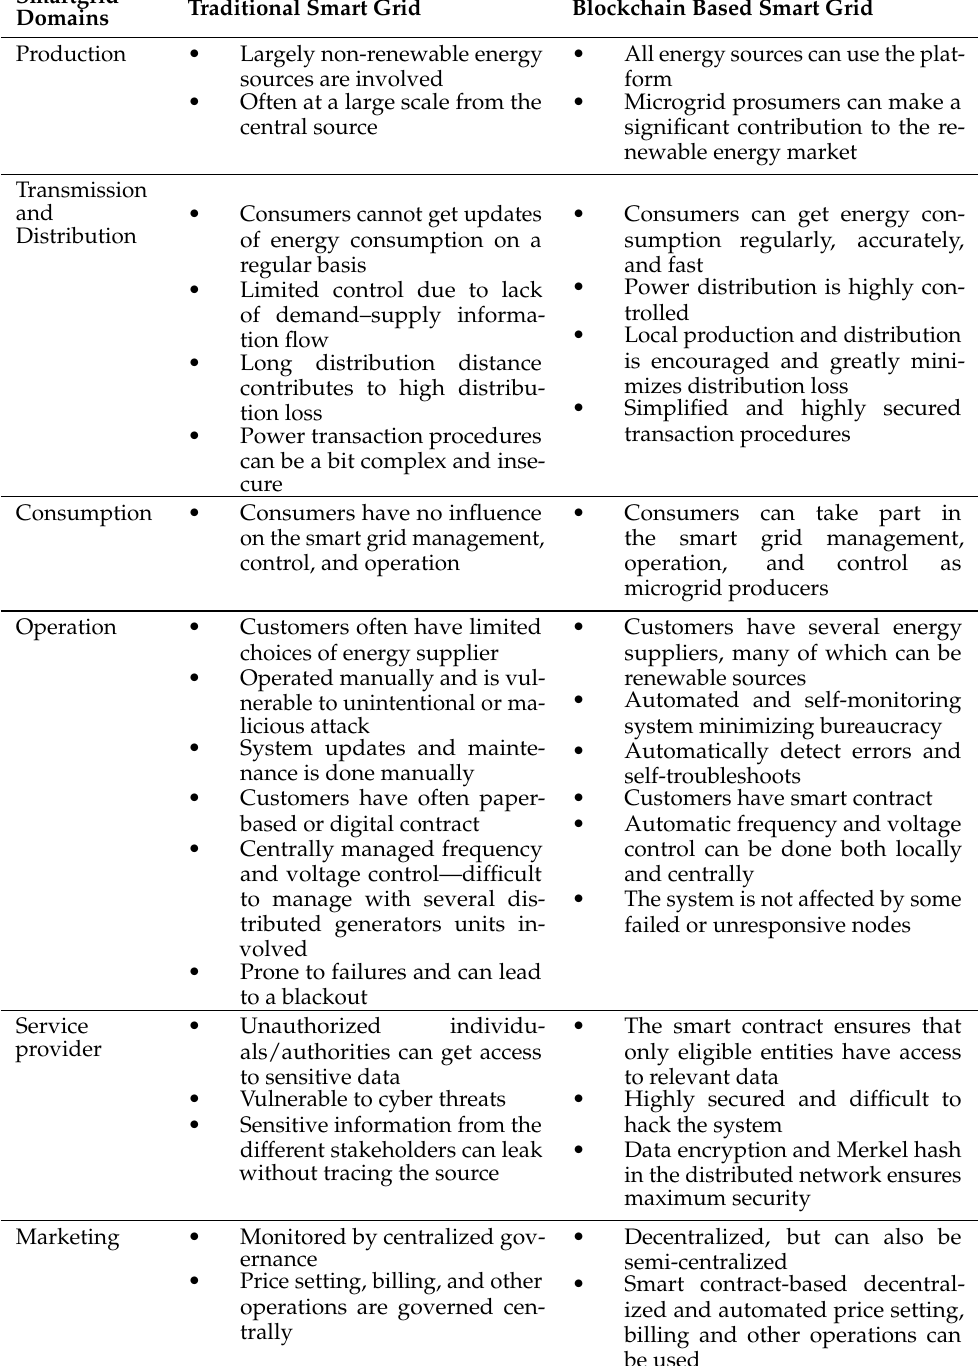
Table 4. Comparison of management, control, and operation between traditional smart grid and blockchain-based smart grid